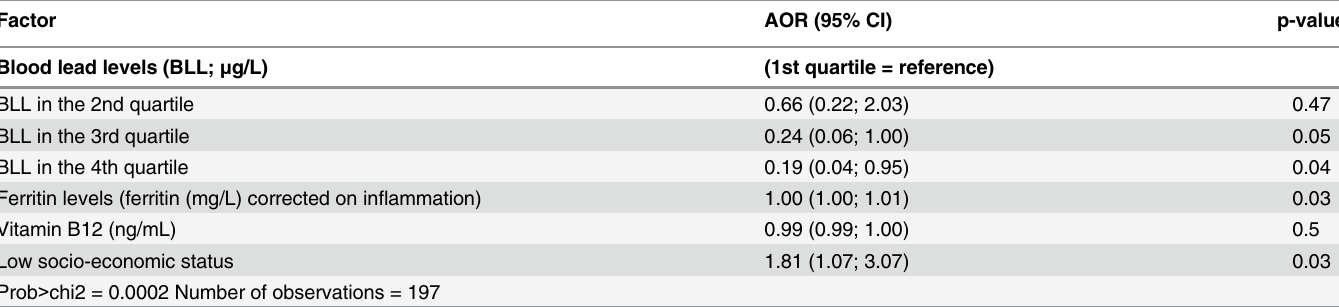
Table 3. Logistic regression on the possibility of having a positive blood smear at 12 months.